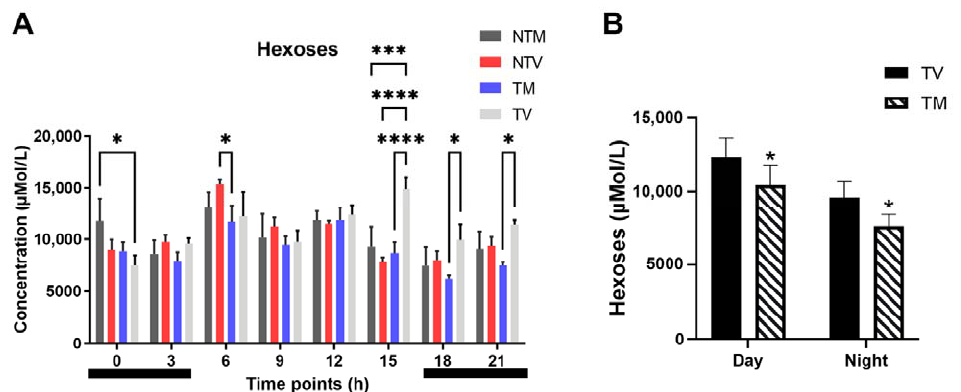
Figure 7. Variation in hexoses (including glucose) evaluated daily in BC-bearing mice after melatonin treatment. ( A ) Plasma levels of hexoses ( µ Mol/L) at the eight time points among the experimental groups (NTM: non-tumor treated with melatonin; NTV: non-tumor treated with vehicle; TM: tumor treated with melatonin; TV: tumor treated with vehicle). Two-way ANOVA complemented with Tukey’s multiple comparisons test. * p < 0.05, *** p < 0.001, **** p < 0.0001. ( B ) Total concentration of hexoses throughout the day and night periods in BC-bearing mice treated with melatonin or receiving vehicle only. Data are expressed as mean ± SD. Student’s t-test. * p < 0.05.